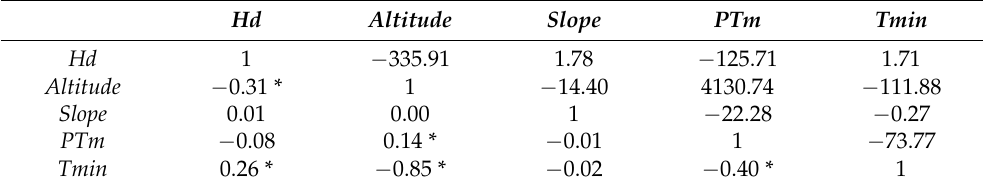
Table 5. Correlation and covariance among topographic and climatic variables with dominant height. Hd